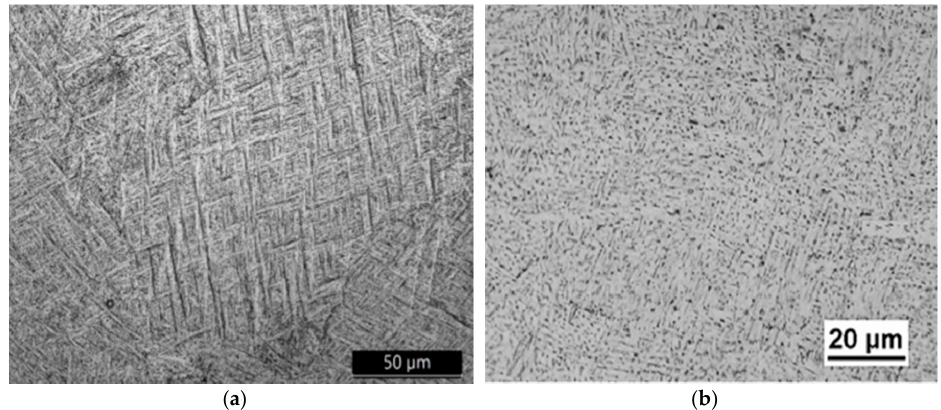
Figure 7. Characteristic microstructure of ( a ) SLM process (fine acicular α′ in columnar original β grains), and ( b ) EBM process ( α + β lamellar). Reproduced from [45,48] respectively, with permission of Elsevier 2017, 2016.